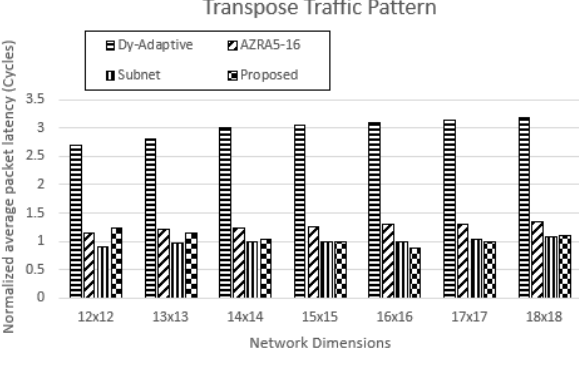
Fig. 19. Comparison of the proposed algorithm with others in terms of normalized average packet latency under synthetic transpose traffic pattern with different network